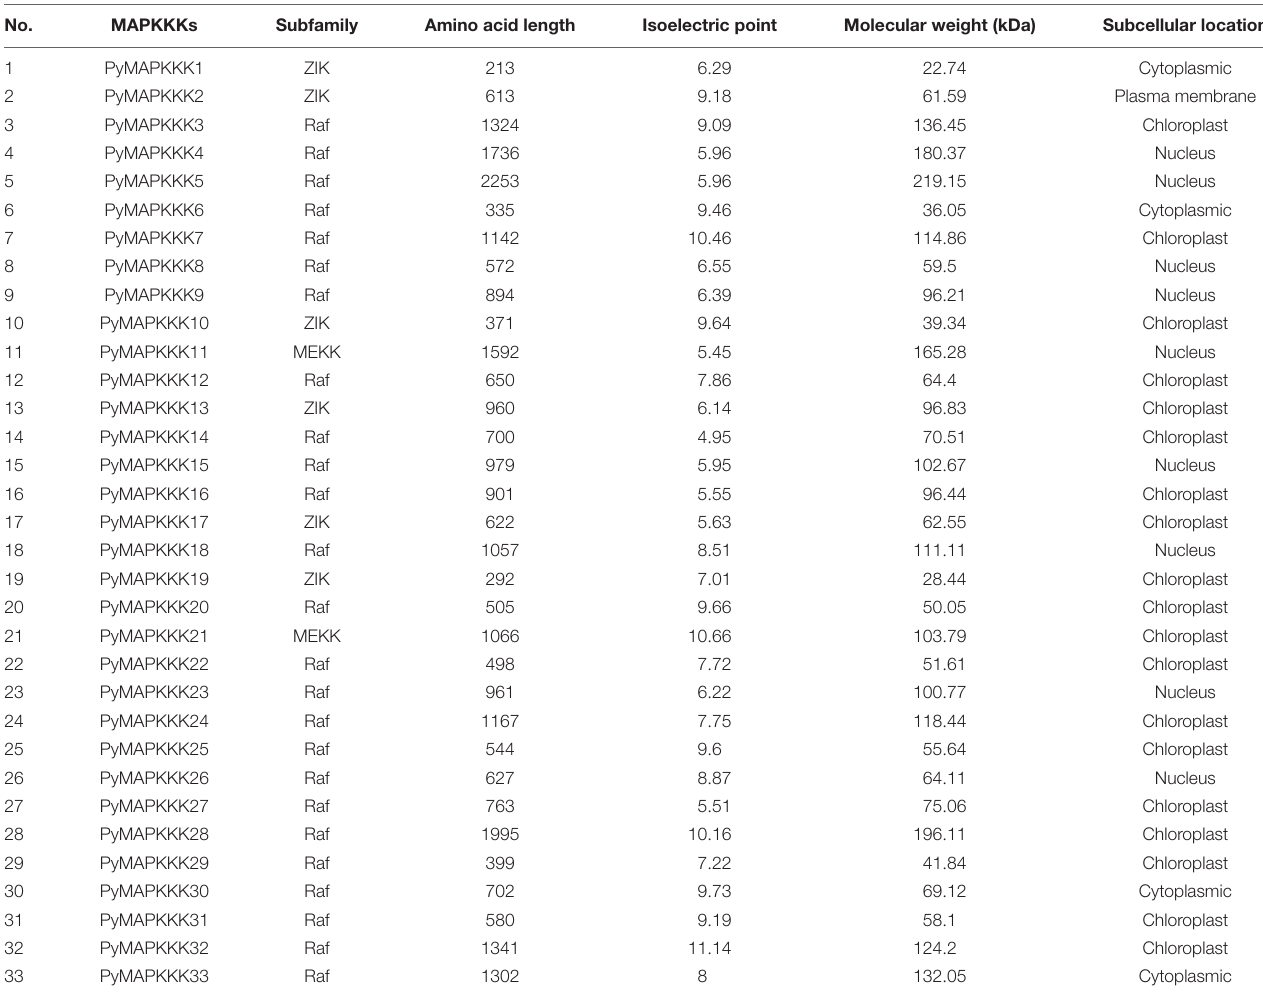
TABLE 1 | Characteristics of MAPKKKs of P.